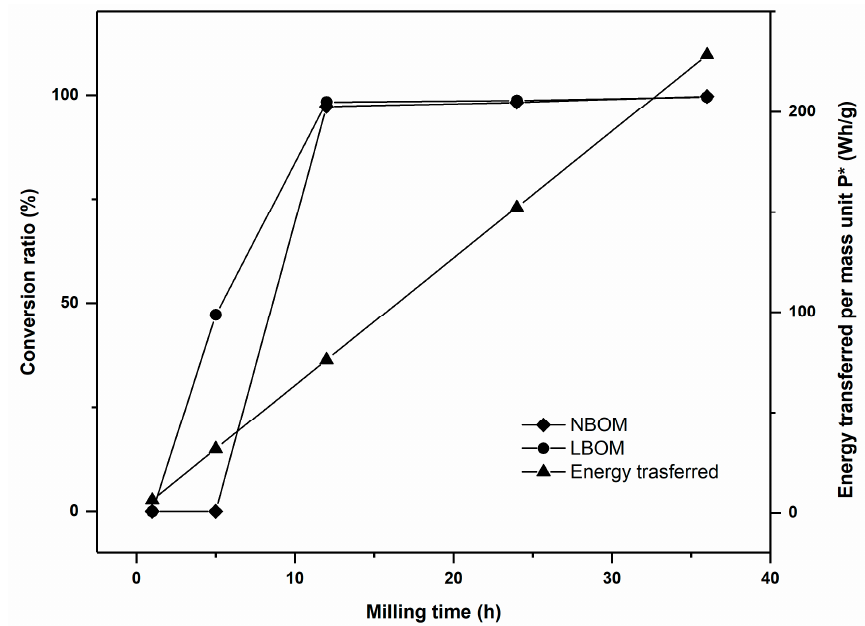
Figure 8. Correlation between conversion and milling energy as a function of the milling time.